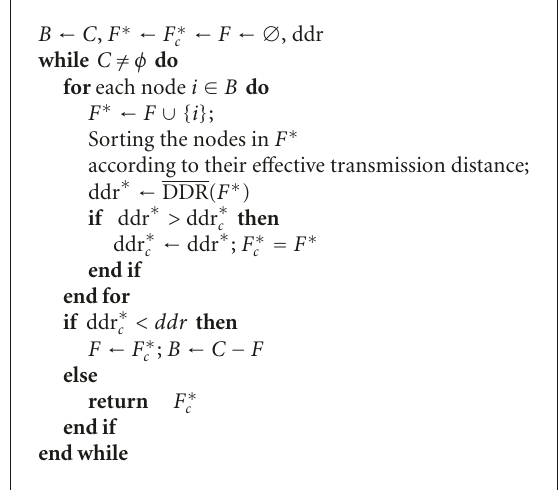
Algorithm 2: Search the optimal set of